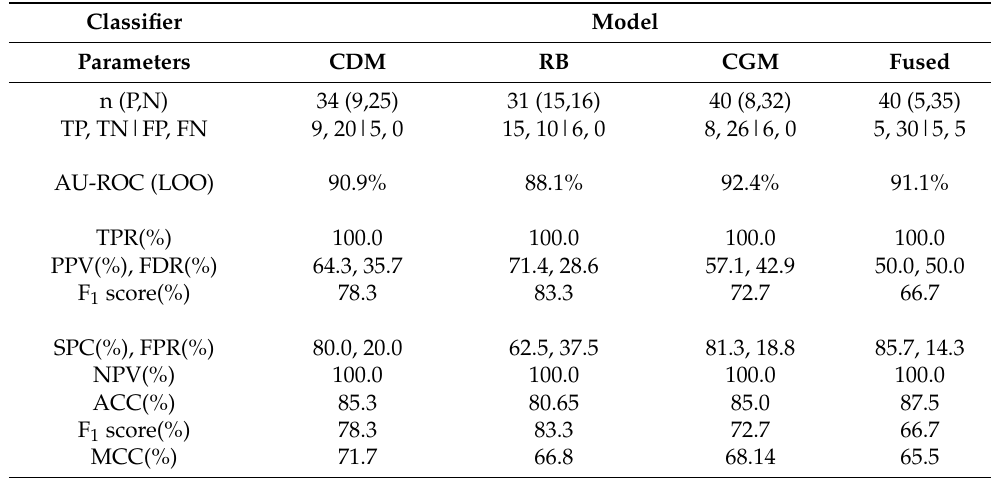
Figure 1. AU-ROC plot for CDM obtained with a LOO cross-validation calculation. Table 2. Classifier parameters for the different SSIR models of this work. See more details in Section